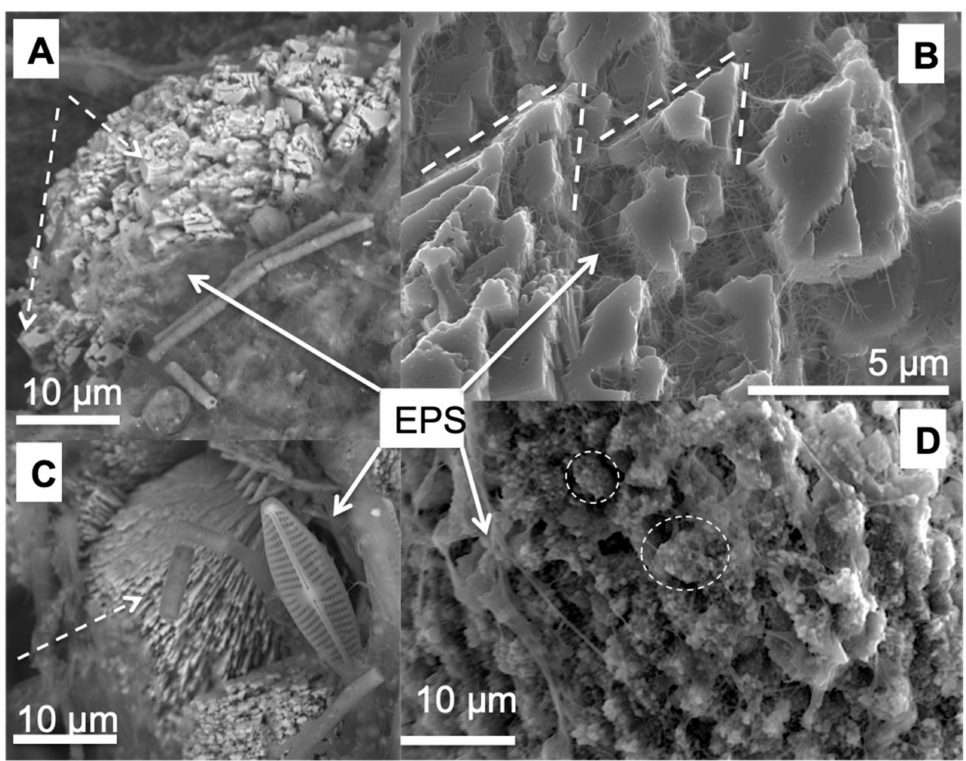
Figure 5. SEM images of the four mesocrystal shapes that form the micro-peloids: ( A ) rhombic / polygonal, ( B ) trigonal, ( C ) needle and ( D ) spherical carbonate crystals (white circles) composed of nano-globules. All mesocrystals were covered by EPS (white arrows).